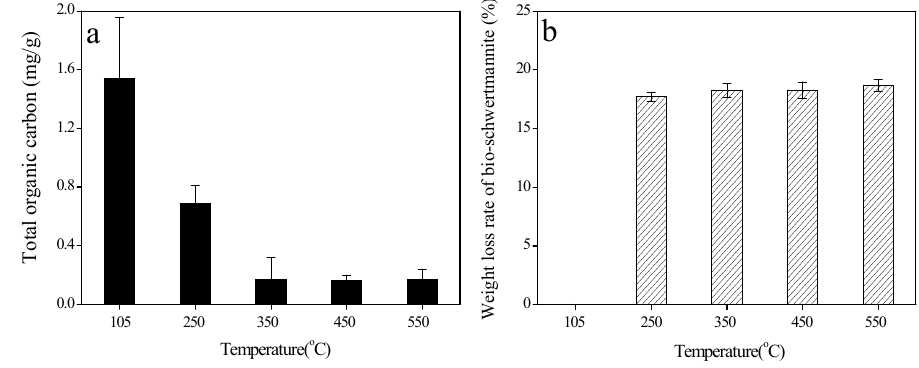
Figure 1. Total organic carbon content ( a ) and weight loss of bio-schwertmannite ( b ) before and after heating.